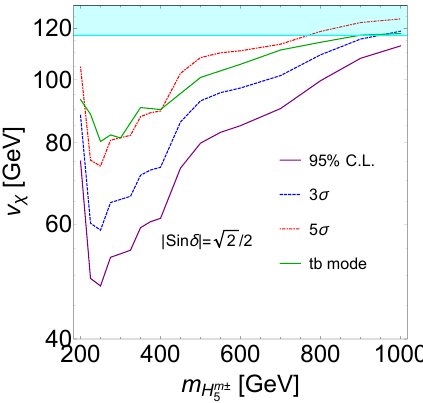
Figure 8 . Sensitivities to the m to 1 TeV with the assumption j sin (cid:14) j = 1 = perturbative unitarity